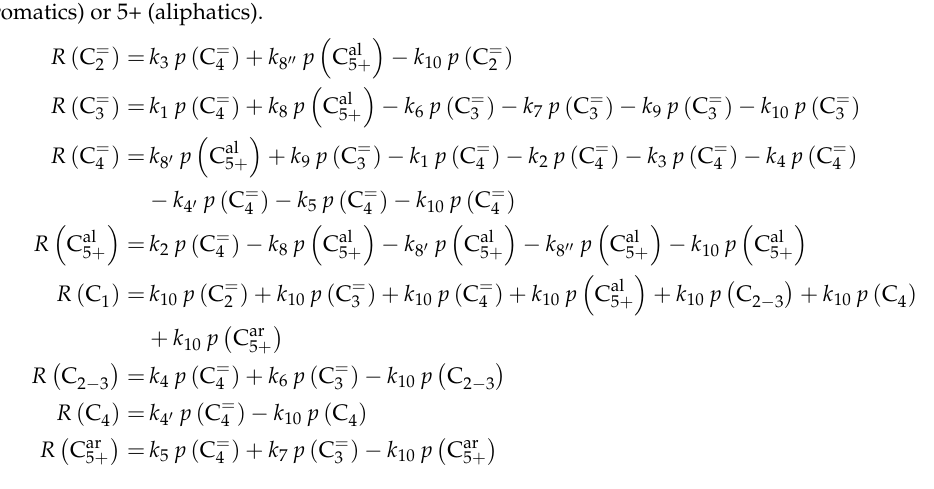
Scheme 3. Net rates of production of the different lumps for the model by Epelde et al. [235] (eight